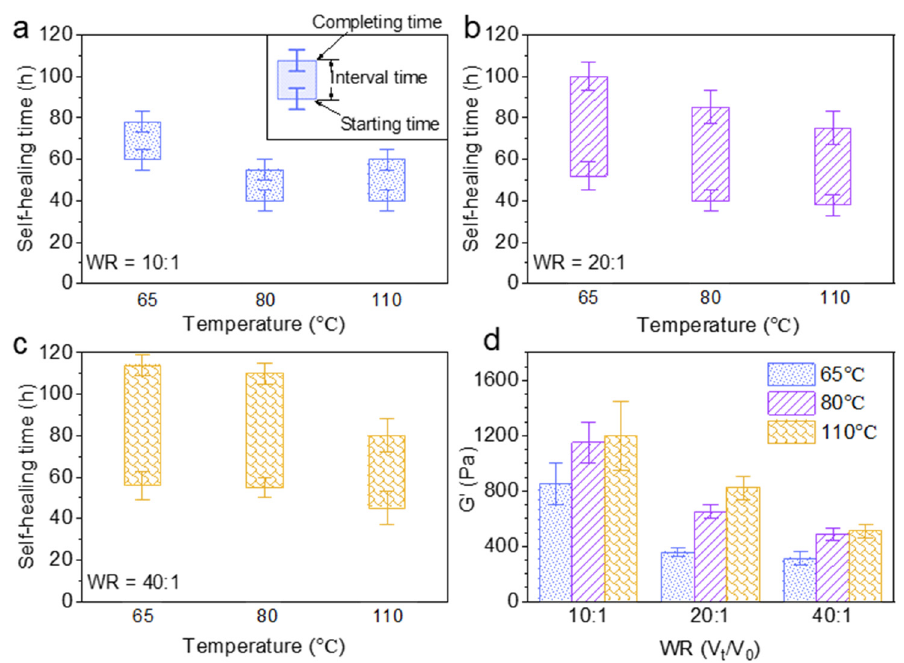
Figure 4. Self-healing time study of Alg-IPNG particles when: ( a ) half swollen; ( b ) fully swollen; ( c ) fully swollen with excess brine; and ( d ) the elastic modulus (G’) of the healed gels.